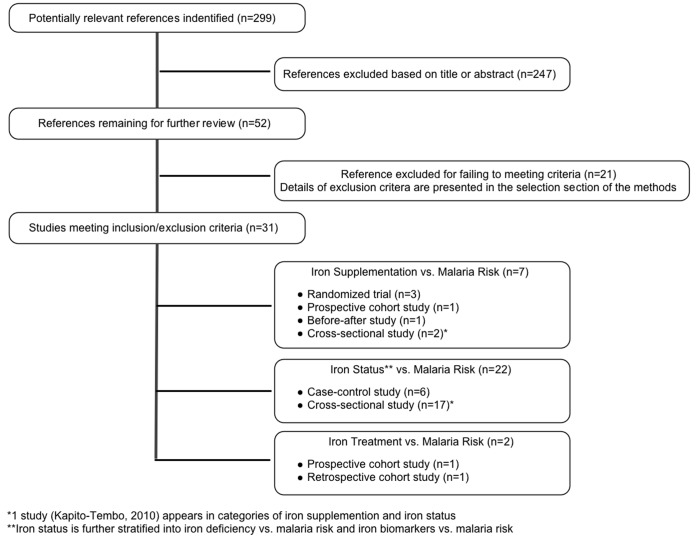
Flow diagram of study selection.Footnote: *1 study (Kapito-Tembo 2010) appears in categories of iron supplementation and iron status. **Iron status is further stratified into iron deficiency vs. malaria risk and iron biomarkers vs. malaria risk.